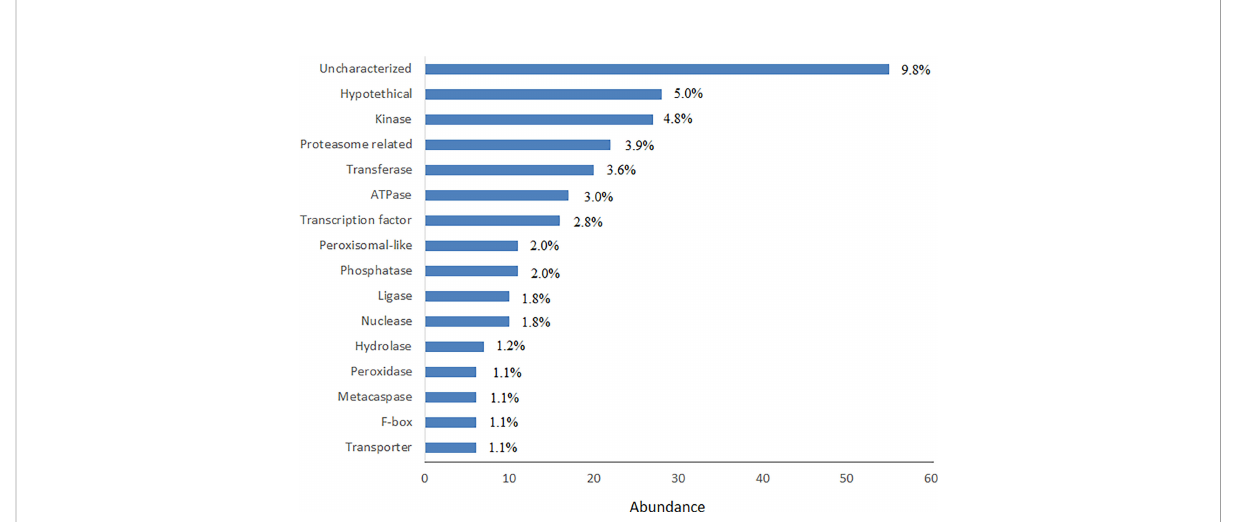
FIGURE 4 Frequency distribution of most abundant functional protein classes in trinucleotide SSR-containing genes. In total, 258 matches were used for drawing the graph.